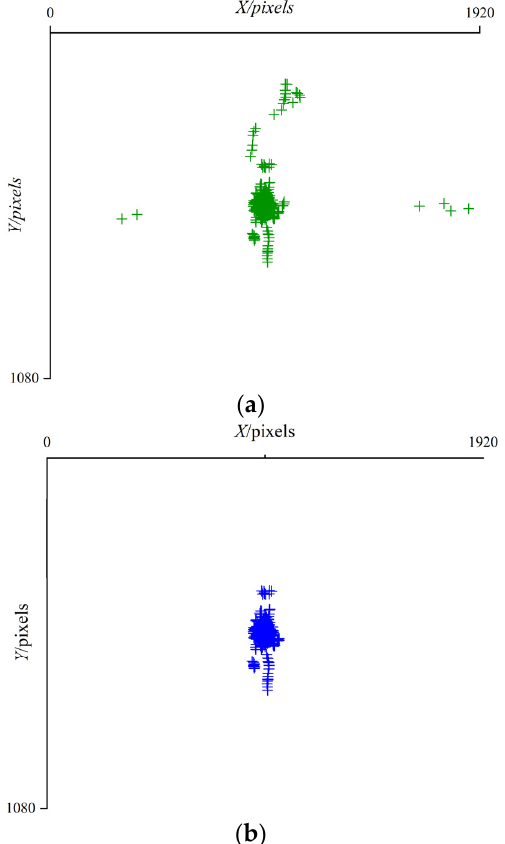
Figure 19. Gaze point distribution during visual aiming. ( a ). Distribution of the original gaze points; ( b ). Distribution of gaze points after classifying.